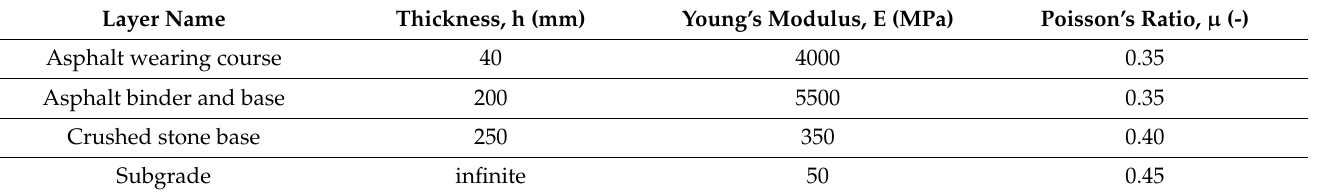
Table 2. Layers and their linear elastic material characteristics in the analysed road pavement